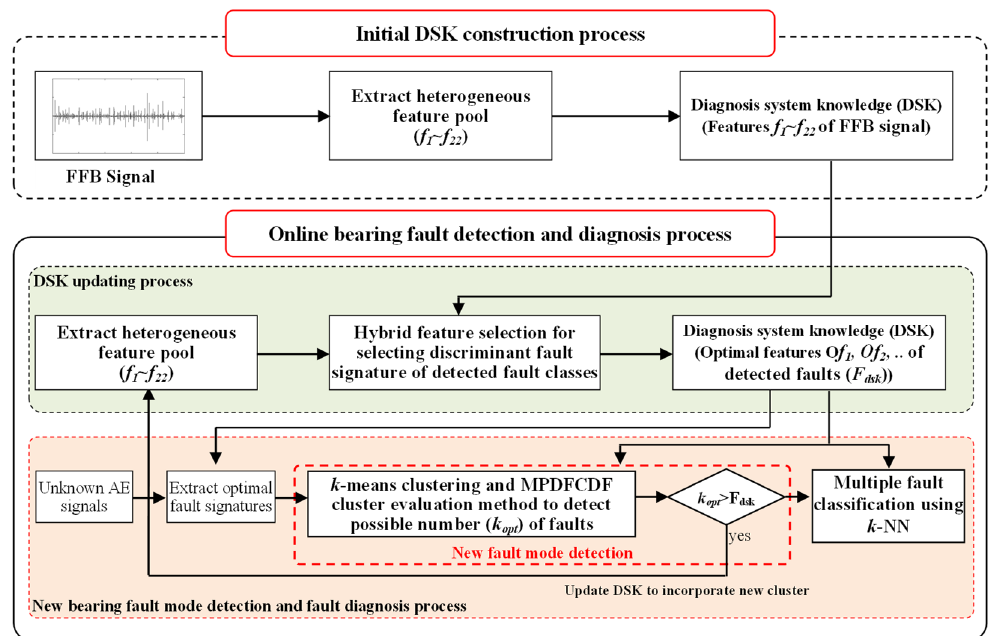
Figure 5. Flow diagram of the proposed online bearing fault diagnosis model, where F dsk is the number of fault modes in the diagnostic system knowledge